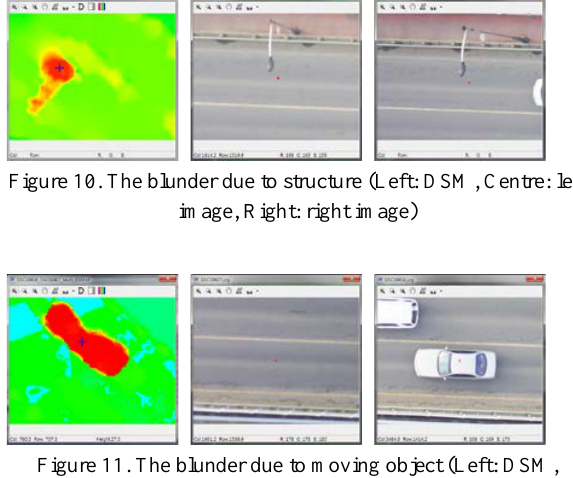
3D point clouds were mapped with the RGB values attached to each point from test dataset and the result is shown ingure 12. For this result we did not apply post-processing techniques, such as point filtering or interpolation.